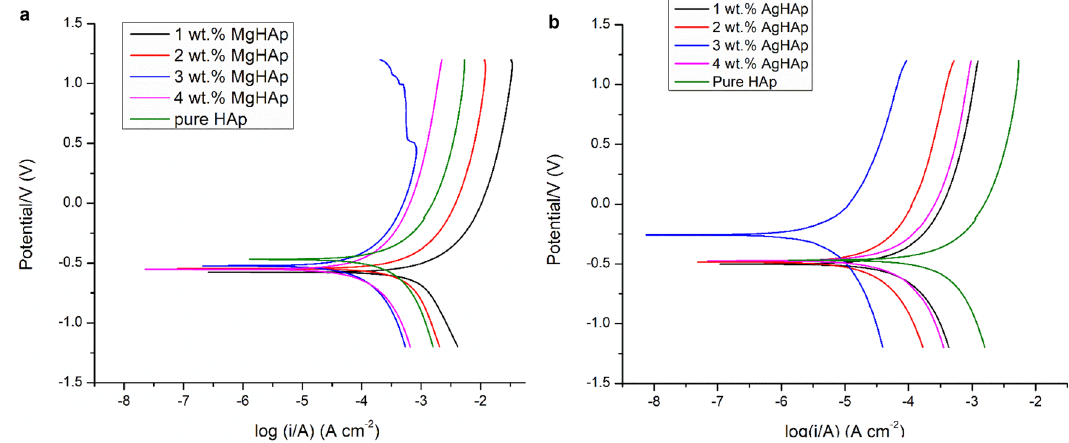
Fig. 5 a The combined Tafel plot for MgHAp samples. b The combined Tafel plots for AgHAp